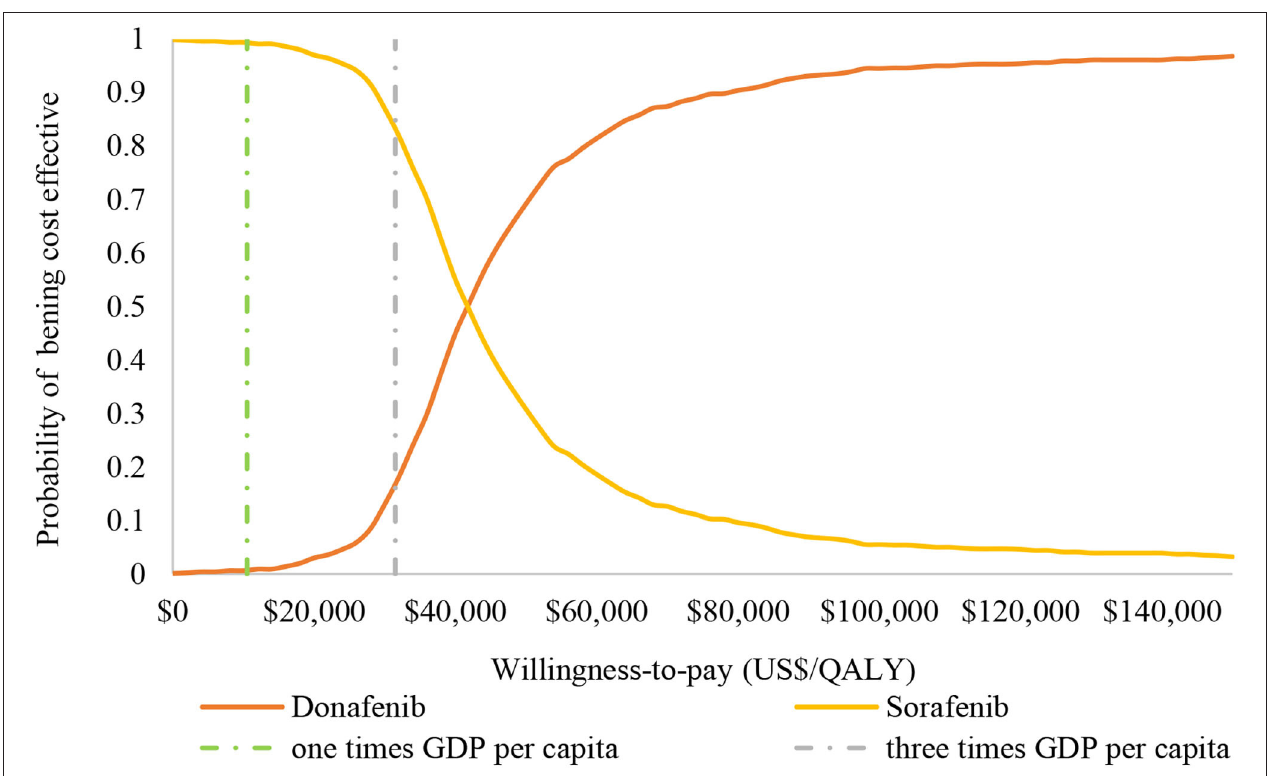
FIGURE 4 | Cost-effectiveness acceptability curve of donafenib vs. sorafenib. GDP, gross domestic product; QALY, quality-adjusted